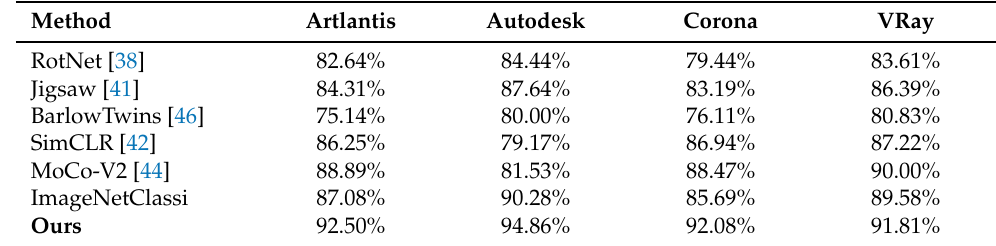
Table 2. Test accuracy of different methods under the linear classification evaluation protocol. The presented results are classification accuracies on the testing set of the four CG forensics datasets of Artlantis, Autodesk, Corona and